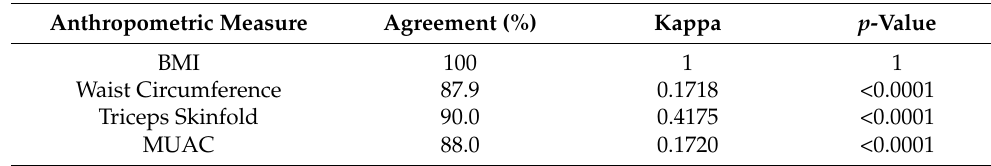
Table 3. Agreement between anthropometric